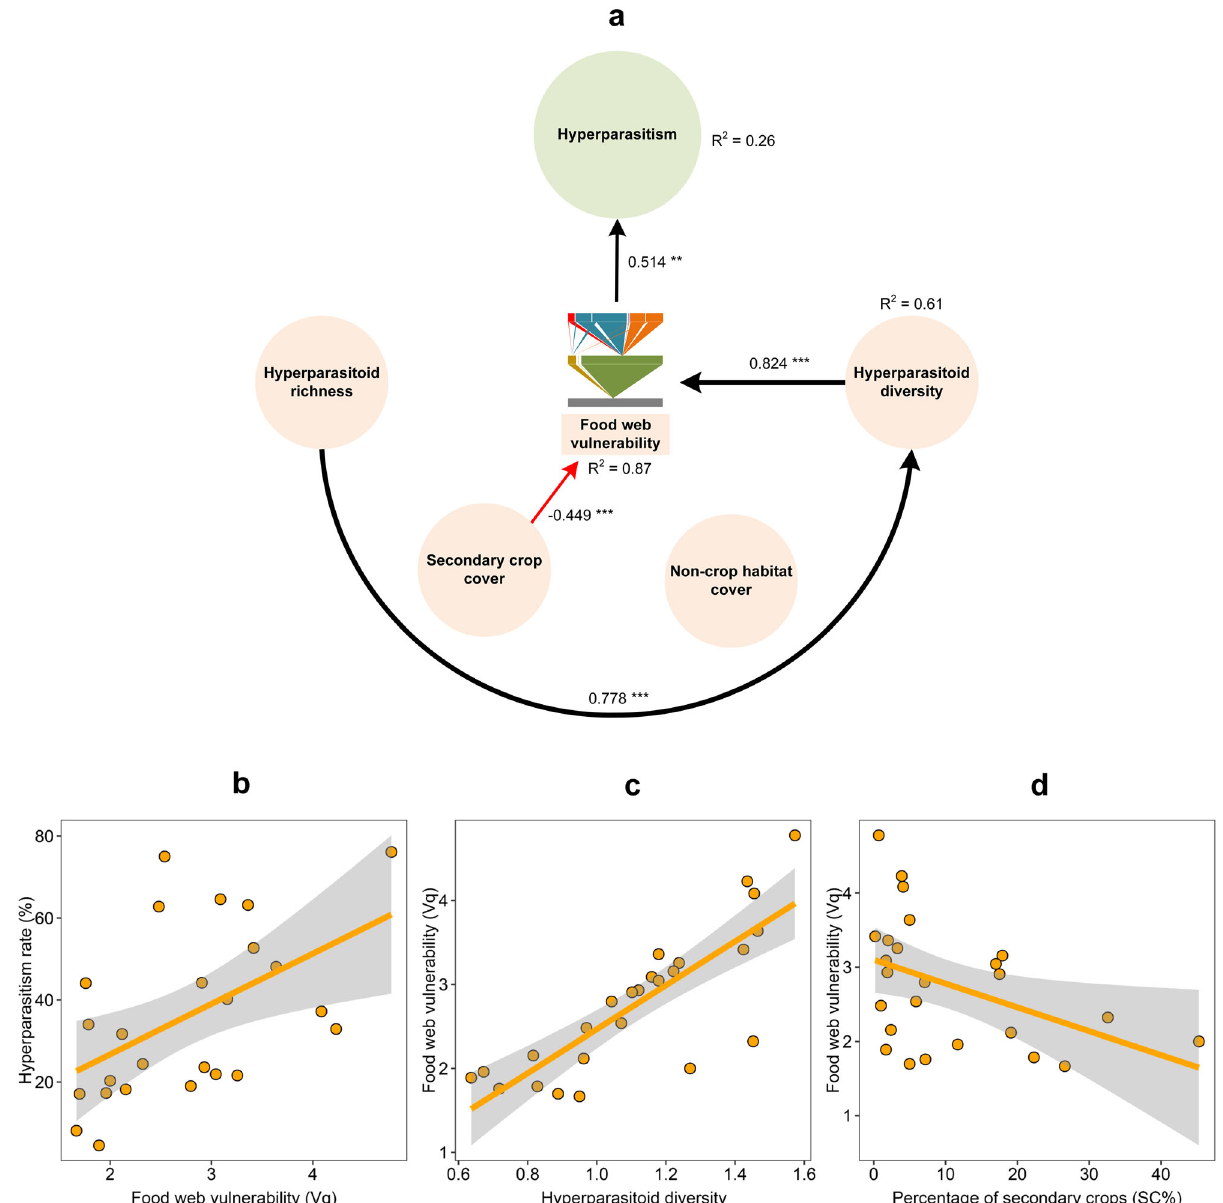
Fig. 3 Causal paths between the ecosystem disservice (EDS) of hyperparasitism and different predictors. In the SEM analysis, EDS is the ultimate response variable, while hyperparasitoid richness and diversity and food web vulnerability (Vq) are both predictors and response variables. Non-crop habitat (NCH) and secondary crop cover (SC) are exogenous variables. The paths reveal both direct and indirect cascading relationships between predictors and response variables. a Shows the paths after removing all nonsigni fi cant paths. Standardized coef fi cients are shown for each path and scaled as line width. Black and red lines indicate either positive or negative relationships, with solid lines representing signi fi cant effects and dotted lines showing nonsigni fi cant effects (* P < 0.05; ** P < 0.01; *** P < 0.001). R 2 shows the explanatory proportion of the total variance for each response variable in the model (Supplementary Table 12). b – d Show the signi fi cant relationships based on SEM analysis, with solid lines and shaded zones indicative of regression lines and 95% con fi dence intervals ( n = 25),